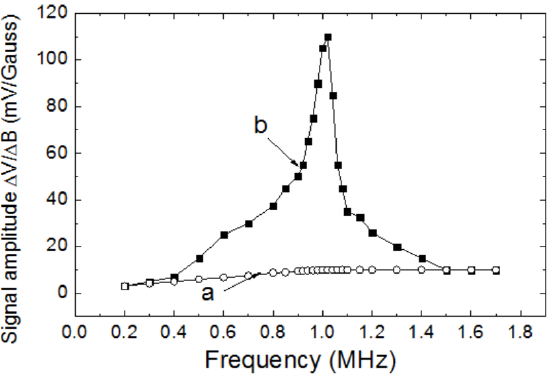
Figure 6. Signal amplitudes of the FeCoSiB amorphous wire magnetic sensor at different frequencies. a: the magnetic sensor without the resonant circuit. b: the magnetic sensor with the resonant circuit.